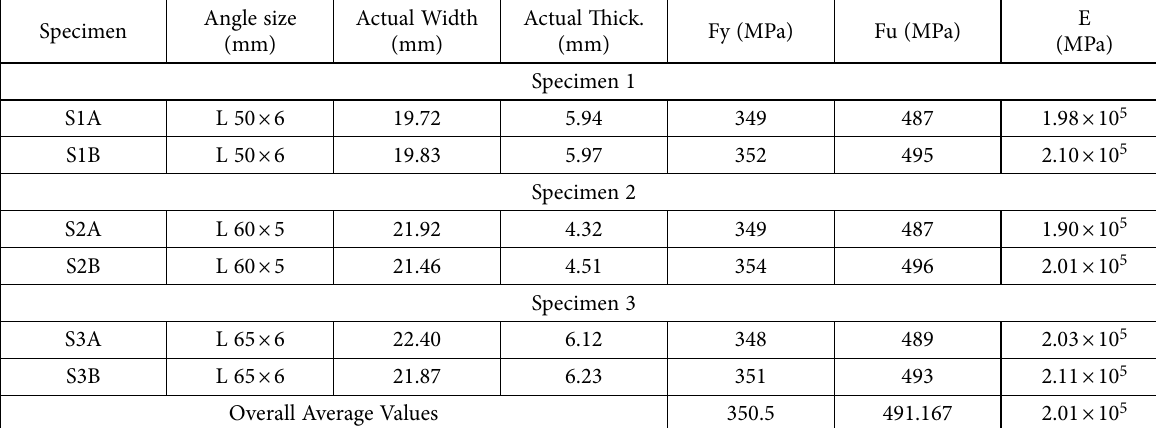
Table 1. Nominal dimension and tensile coupon test results